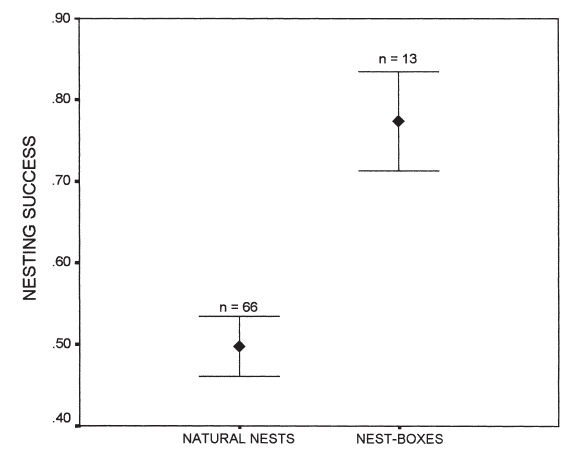
F IG . 1. – Mean breeding success ( ± SE) in natural nests and nest- boxes during the five years of study. We considered the average breeding success of pairs with at least three recorded breeding